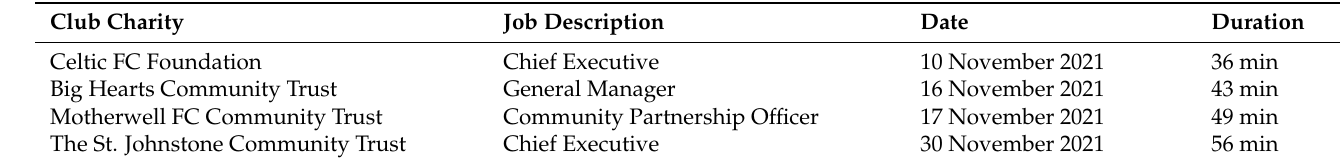
Table 2. Participants and interview